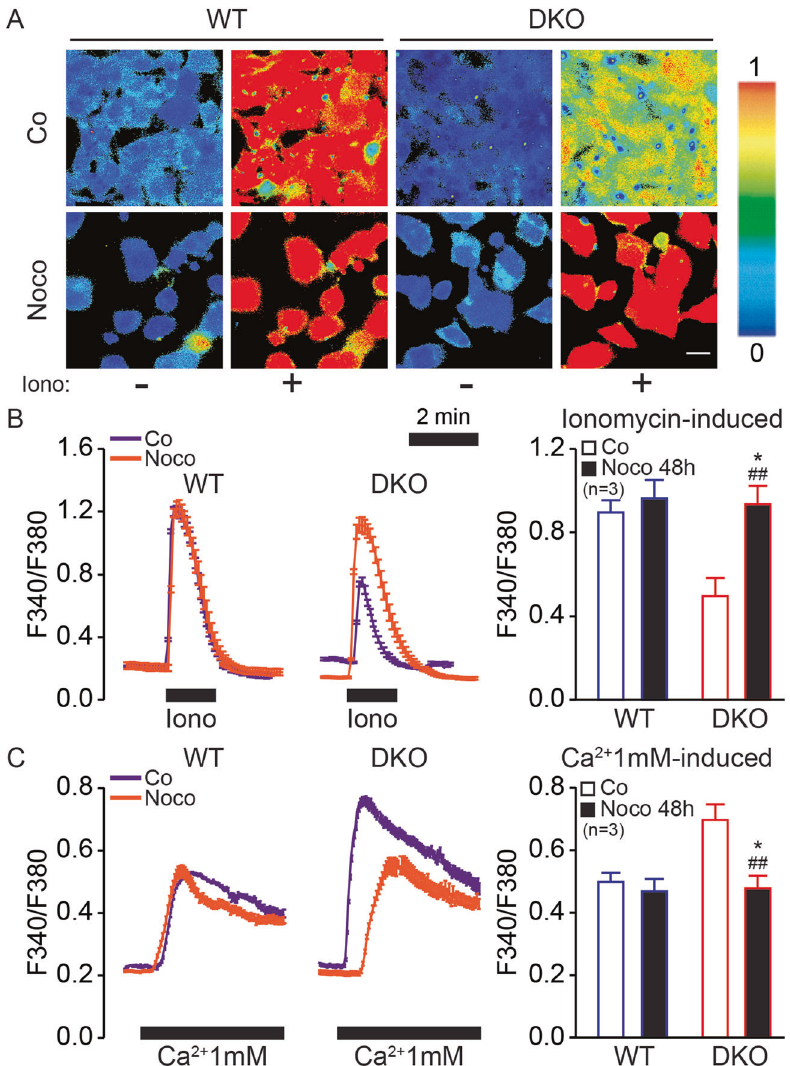
with red contours represent Bax/Bak DKO cells. White columns represent control cells and black columns represent treated cells. Error bars indicate SEM. Data were compared by R software using standard linear model inference, “ lm ” function. ## p < 0.01 treatment vs. control. * p < 0.05, for treatment effect, DKO vs. WT. Scale bar, 10 μ